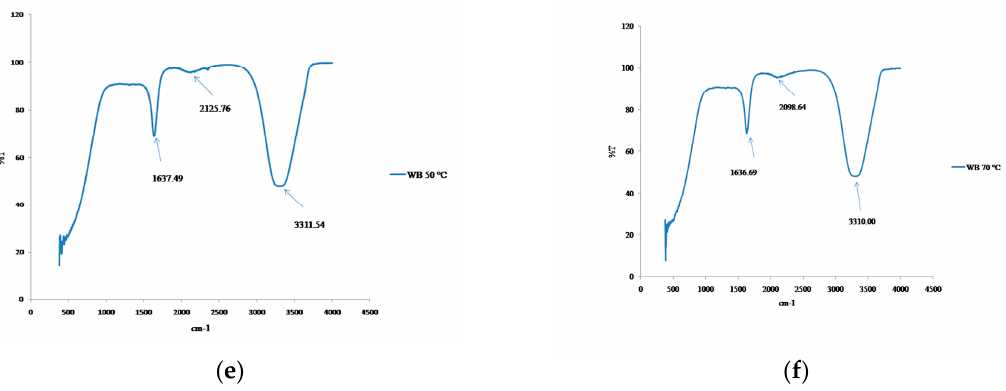
Figure 5. Fourier-transform infrared (FTIR) spectroscopy analysis of amaranth extract. ( a ) Ultra-sonication at 30 °C, ( b ) ultra-sonication at 50 °C, ( c ) ultra-sonication at 70 °C, ( d ) agitation in water bath (WB) at 30 °C, ( e ) agitation water bath (WB) at 50 °C, and ( f ) agitation water bath (WB) at 70 °C.